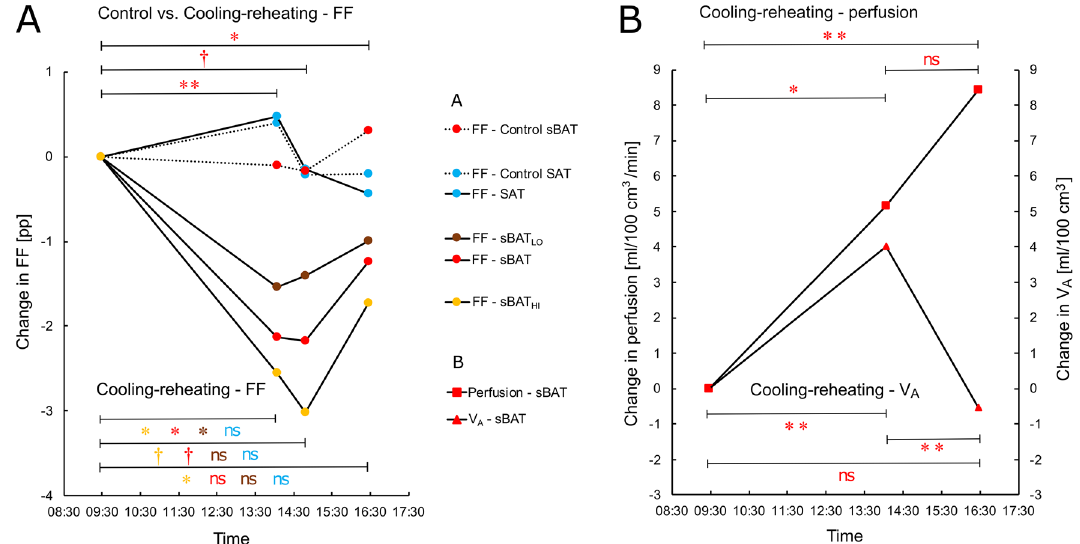
Figure 4. Changes in FF, perfusion and V A , within sBAT and SAT, with respect to baseline. (A) Changes in FF during the Cooling-reheating and Control protocols, with significance bars indicating changes during the Cooling-reheating protocol (at the bottom) and differences between the two protocols (at the top). (B) Changes in perfusion and V A during the Cooling-reheating protocol indicated with significance bars. Measurements represent group mean values based on complete data available for estimating the changes between individual time points, i.e. different group mean values can be based on a different number of subjects. Solid line, Cooling- reheating protocol. Dotted line, Control protocol. Time, approximate mean session time for all subjects.